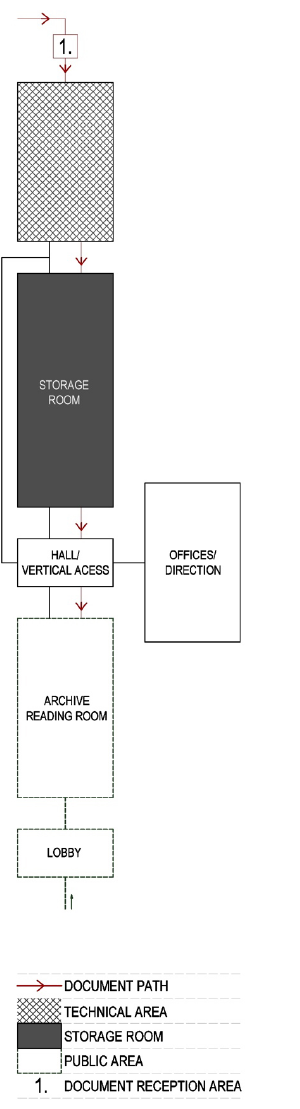
Figure 9. Proposed spatial organization